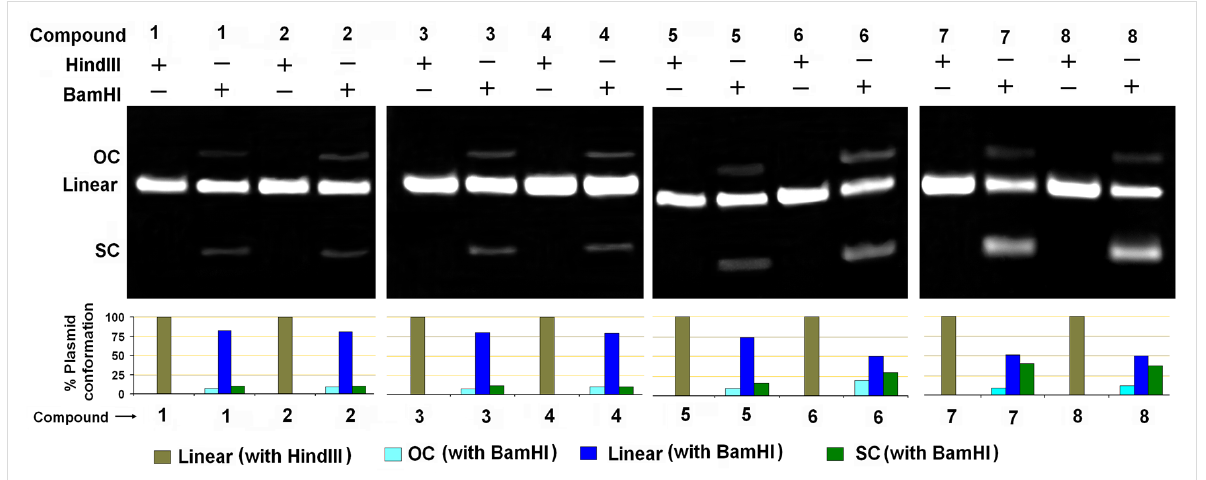
Figure 2: Effect of triptycene derivatives on the restriction endonuclease activity of HindIII and BamHI enzymes on pUC19 plasmid. Agarose gel (top) shows the presence of the different forms of the plasmid following incubation with the compound and the respective restriction endonuclease. Quanti- tative estimation of the different forms of pUC19 in the corresponding gel lanes are shown in the bar diagram (bottom). OC and SC represent the open circular and the supercoiled form of pUC19.